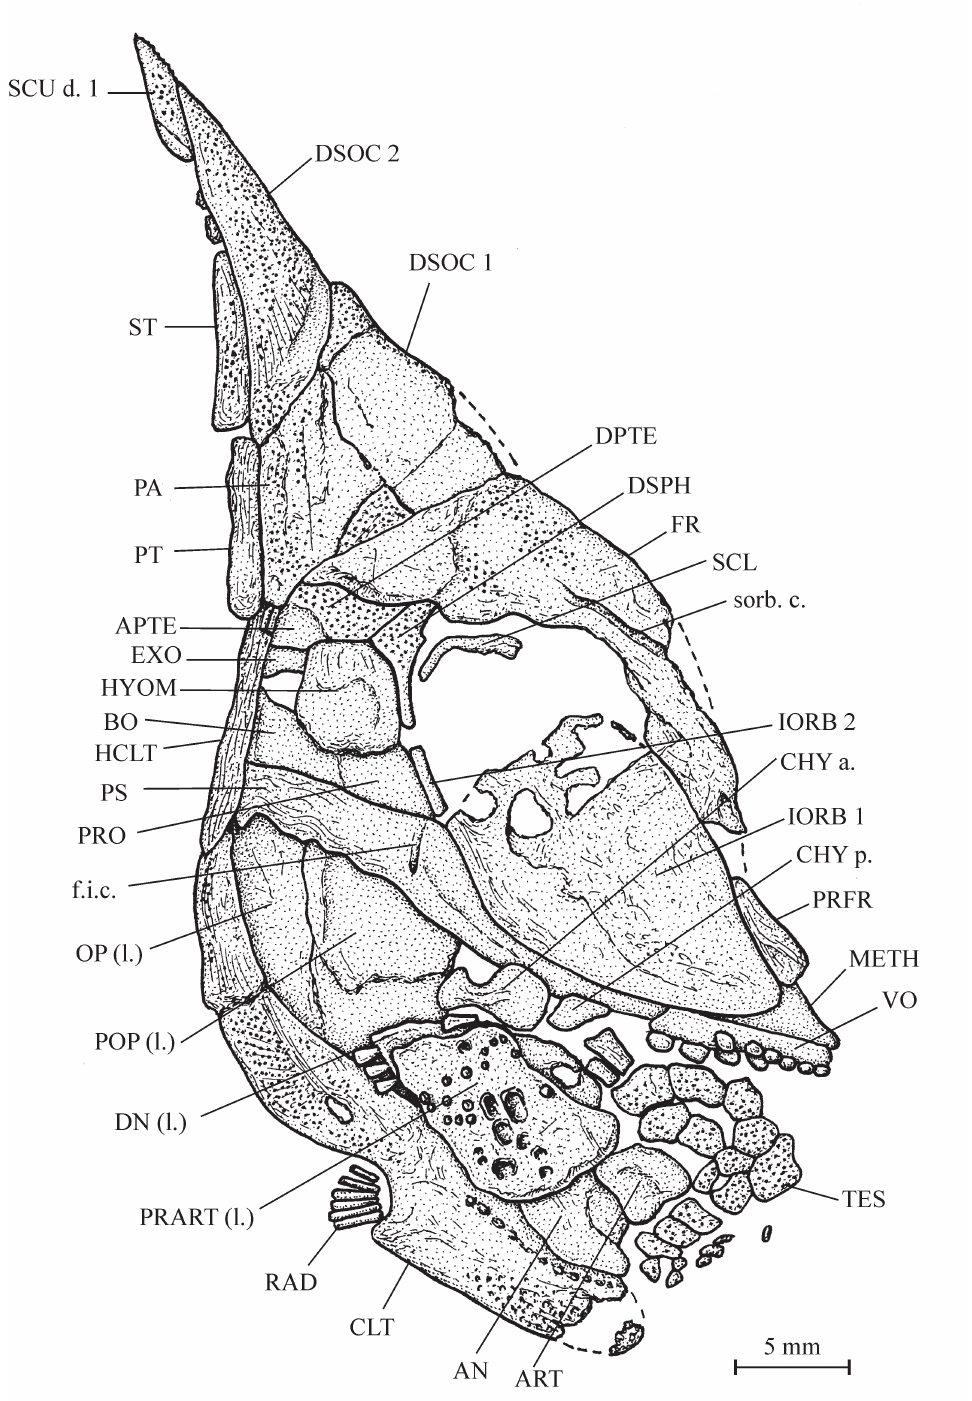
Fig. 21. Brembodus ridens Tintori, 1980. Skull and pectoral girdle of sample CLC J-420. The right opercle and preopercle, the ventral part of the hyomandibula, the maxillae, the premaxillae and the right mandible are lost. The left mandible and the hyoid bar are displaced due to the fossilization. The left mandible is seen from its inner face. The first tooth of the dentary is displaced under the anterior ceratohyal. A small part of the inner face of the left opercle and preopercle is